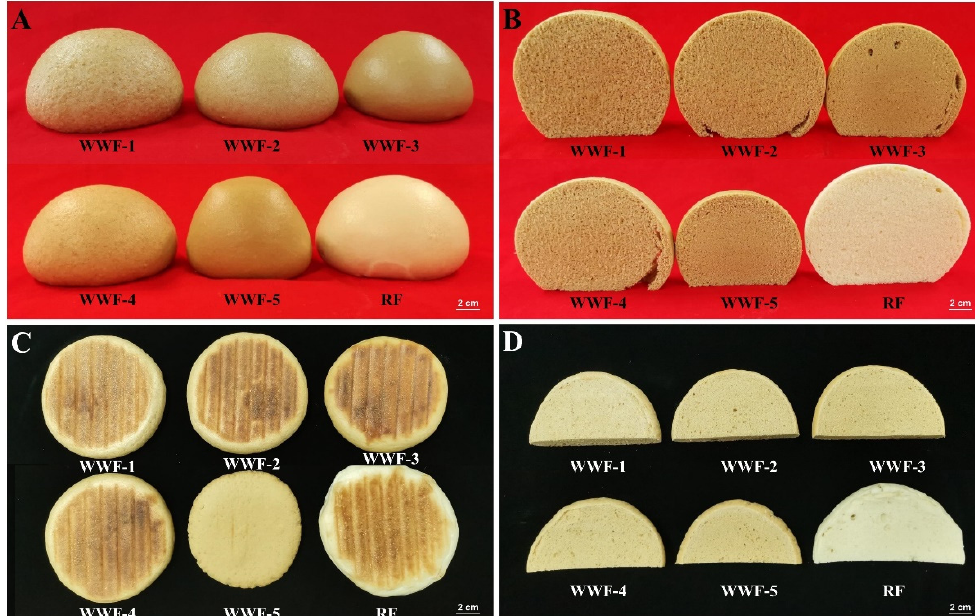
Figure 2. Appearance of CSB ( A ), internal structures of CSB ( B ), appearance of CLP ( C ) and internal structures of CLP ( D ) produced from different whole wheat flours. CSB: Chinese steamed bread; CLP: Chinese leavened pancakes. WWF-1: total reconstitution of brans grinded by hammer mill; WWF-2: total reconstitution of brans grinded by jet mill at 45 Hz. WWF-3: total reconstitution of brans grinded by jet mill at 65 Hz; WWF-4: entire grains grinded by jet mill at 45 Hz; WWF-5: entire